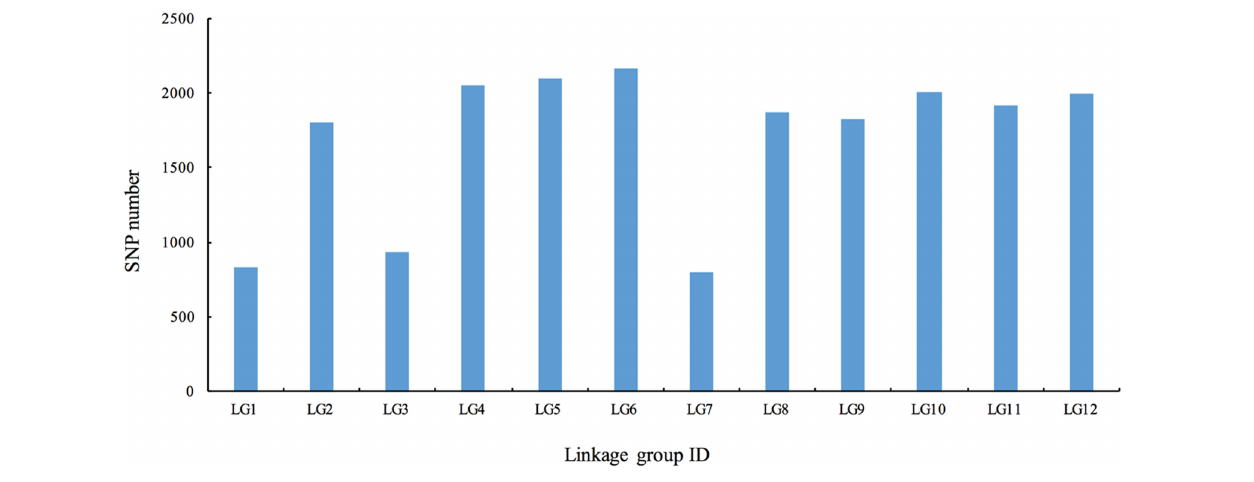
at Beijing Biomarker Technologies Corporation 1 . Raw reads were assigned to different samples according to the barcode